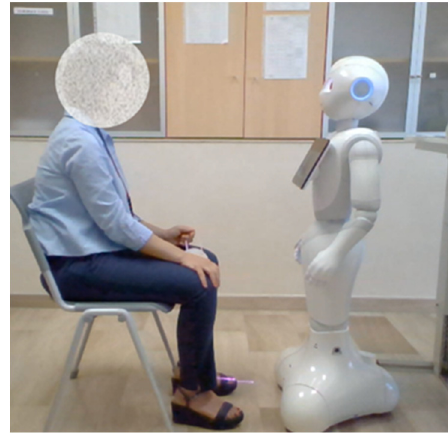
Figure 2. Overview of experimental context.